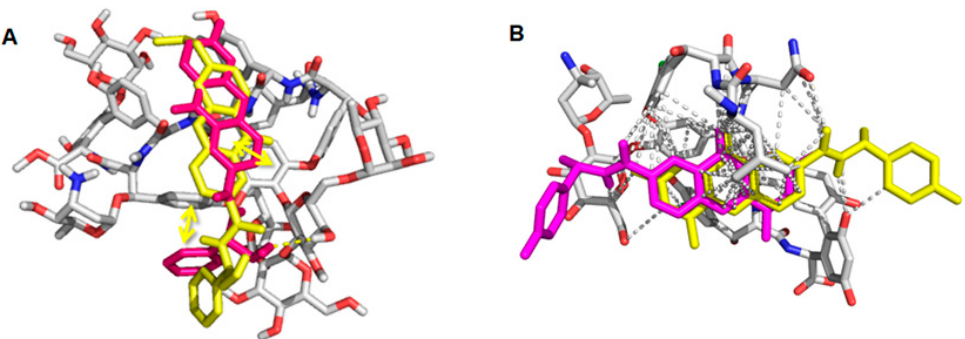
Figure 9. ( A ) Analyte 9 docked on ristocetin selector; ( B ) Analyte 25 docked on vancomycin selector. Chiral selectors are represented in sticks with C, O, N, and Cl atoms colored in grey, red, blue, and green, respectively. ( S ) and ( R ) enantiomers are represented with magenta and yellow sticks, respectively. In ( A ), hydrogen interactions and π -stacking interactions are represented with dashes and double arrow, respectively. In ( B ), all the interactions (apolar and polar) are represented as grey dashes.